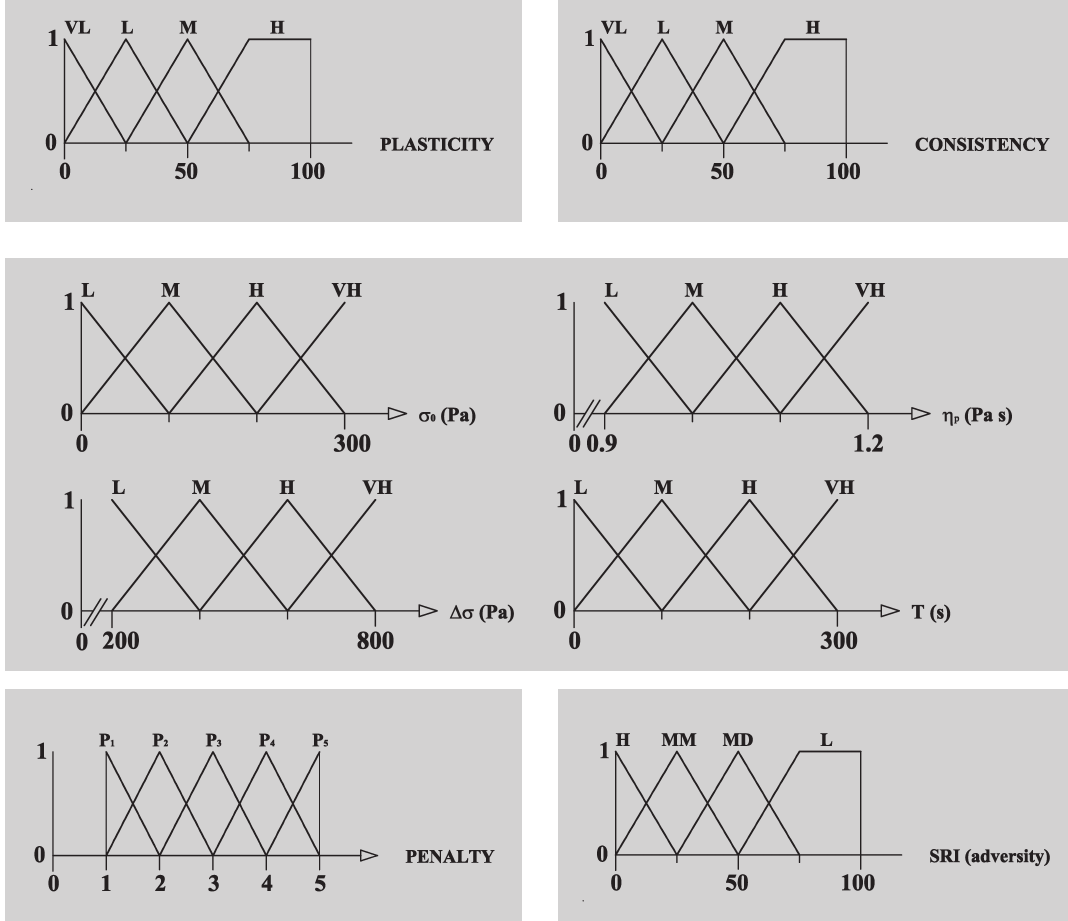
Figure 5 (left above): VERY LOW, LOW, MEDIUM, HIGH: plasticity classes (fuzzy sets) Figure 6 (middle): LOW, MEDIUM, HIGH, VERY HIGH: independent rheolog- ical variables classes (fuzzy sets (data from [18]). Figure 7 (right above): VERY LOW, LOW, MEDIUM, HIGH: consistency classes (fuzzy sets). Figure 8 (left below): Membership functions of penalty Pi due to increase in sand-to-lime putty ratio. Figure 9 (right below): HIGH, MEDIUM, MODER- ATE, LOW ADVERSITY: sand rheo-index, SRI, classes (fuzzy